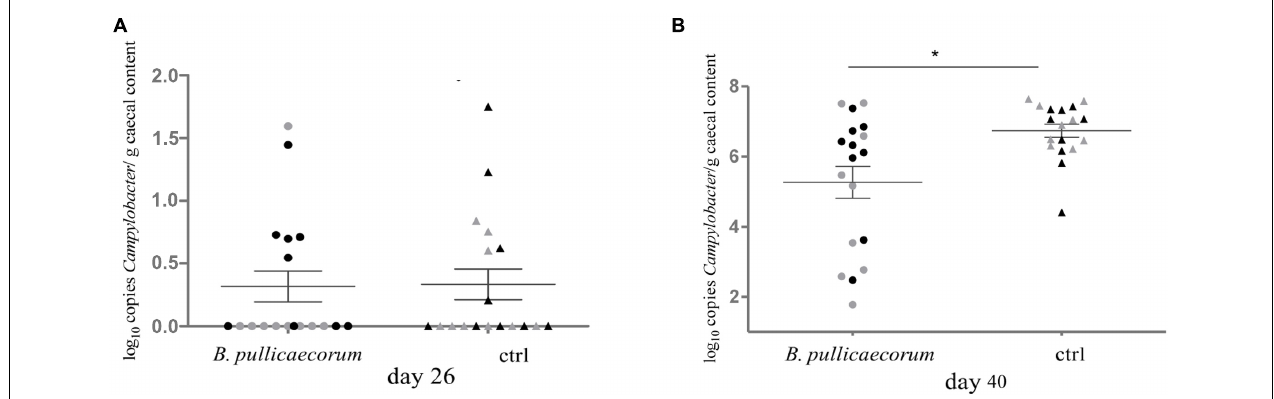
FIGURE 2 | Quantification using qPCR of Campylobacter bacteria in caecal content from nine male ( • ) and nine female ( • ) B. pullicaecorum treated and nine male ( (cid:78) ) and nine female ( (cid:78) ) untreated chickens on day 26 (A) and day 40 (B). Bacterial density is expressed as log 10 copy number of 16S rRNA genes of Campylobacter per g of caecal content. ∗ p = 0.0169.